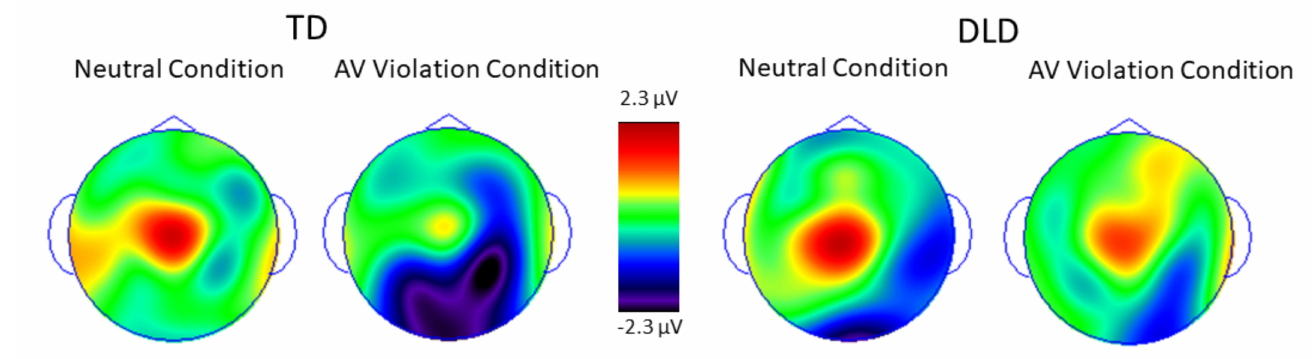
Figure 5. Voltage distribution 150–250 ms post-stimulus onset in deviant—standard difference waves. Note the significant negative voltage over posterior scalp in the AV violation condition in children with TD but not in children with DLD.